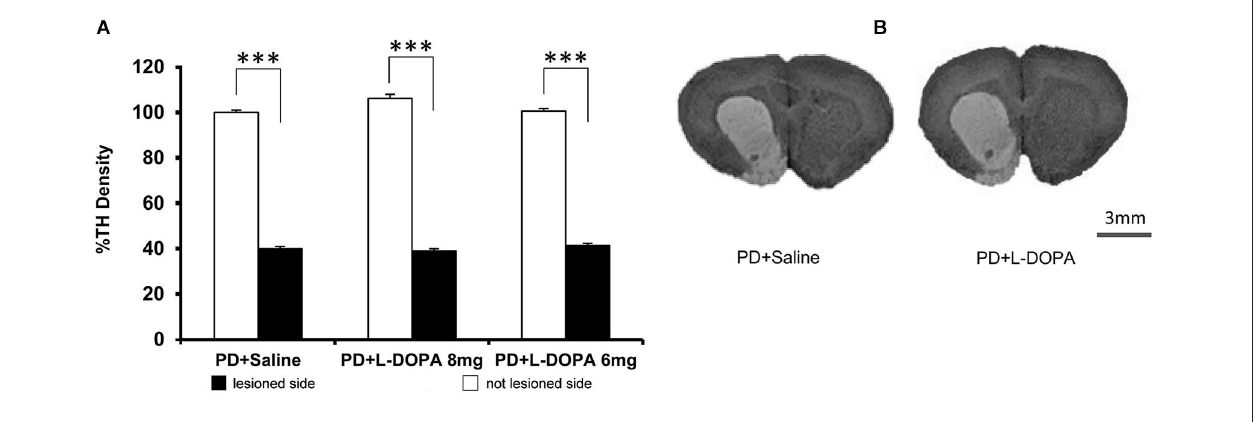
density in the DA-denervated side compared to the contralateral side within each group (*** p < 0.001 vs. contralateral side). (B) Representative image of DA denervation in the right side of the striatum. Scale bar = 3 mm.